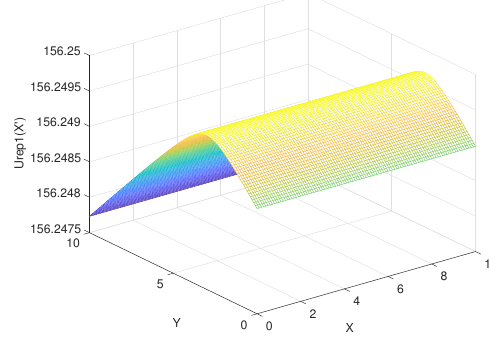
Figure 10. The influence of δ change rate on U rep